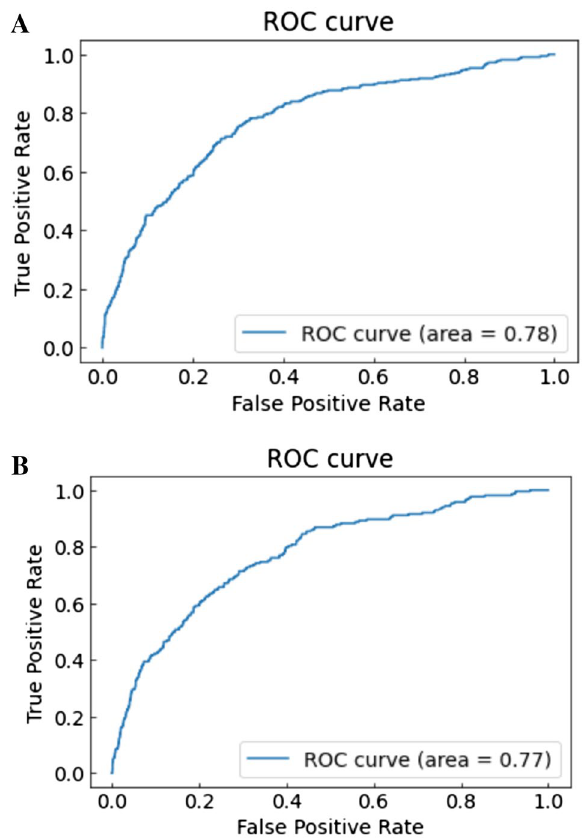
Figure 4. ( A ) ROC curve with training datasets using the light GBM with age, eGFR, preprocedural hemoglobin, ST-elevation myocardial infarction, non-ST elevation myocardial infarction/unstable angina, heart failure symptoms at admission and cardiogenic shock. ( B ) ROC curve with testing datasets using the light GBM age, eGFR, preprocedural hemoglobin, ST-elevation myocardial infarction, non-ST elevation myocardial infarction/unstable angina, heart failure symptoms at admission, and cardiogenic shock. Abbreviations: GFR: glomerular filtration rate, ROC: receiver operating